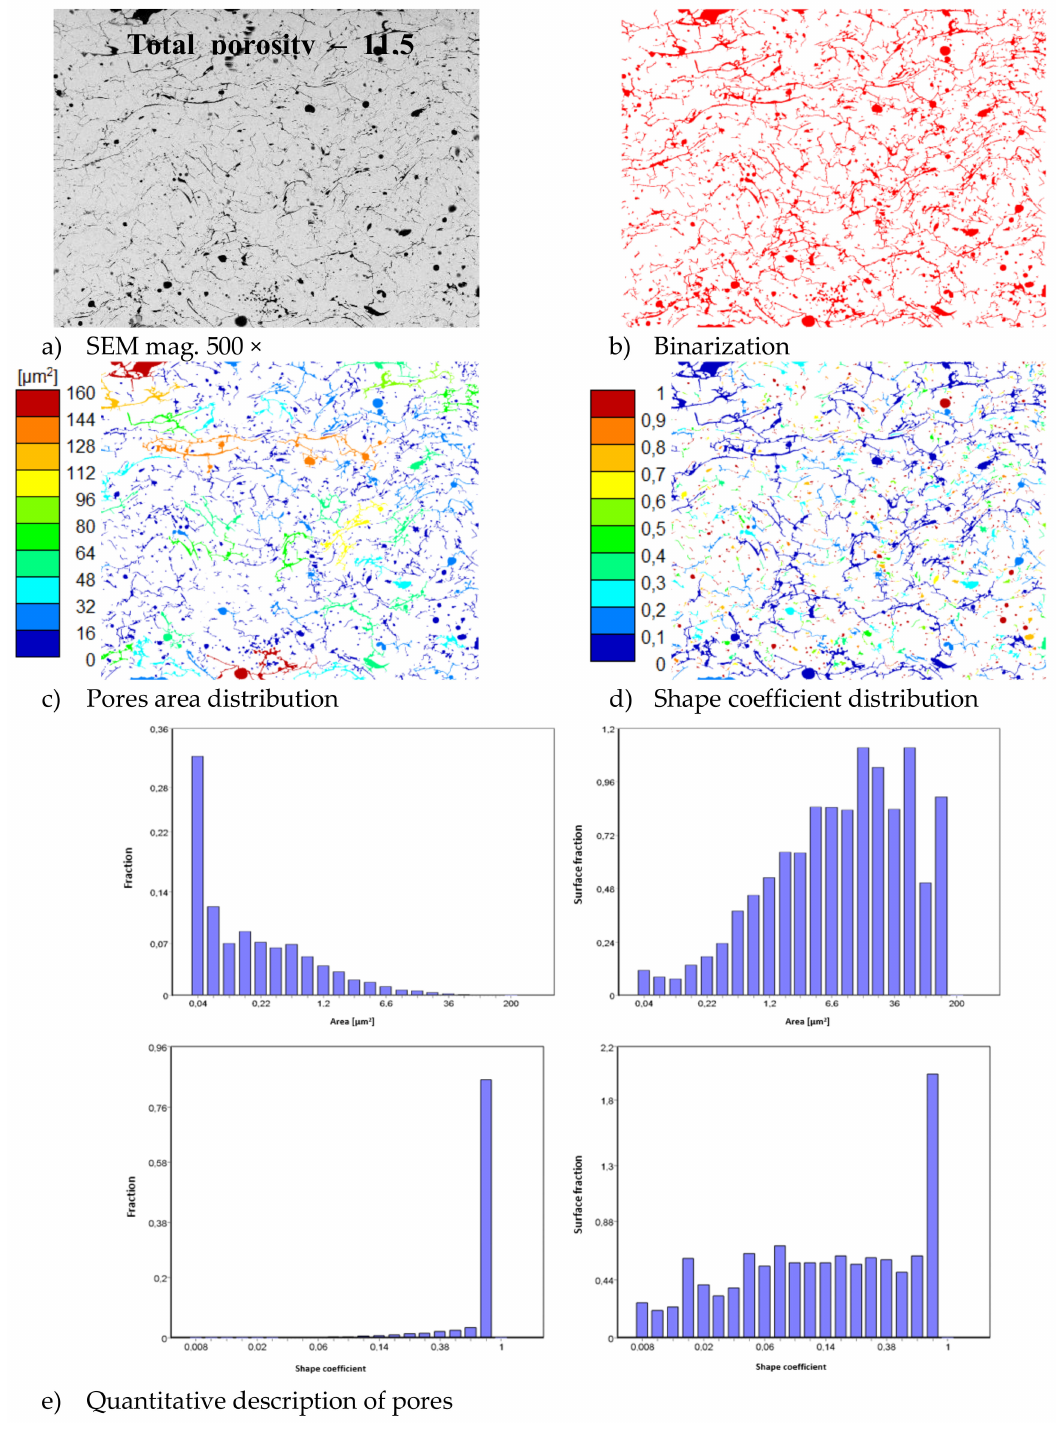
Figure 6. The image analysis results describe pores and voids morphology from quantitative and qualitative points of view for the monolayered La 2 Zr 2 O 7 system: ( a ) SEM image, ( b ) binarization of pores and cracks, ( c ) visual evaluation of pores area distribution, ( d ) visual evaluation of pores shape coe ffi cient distribution, ( e ) quantitative evaluation of pores area and shape coe ffi cient